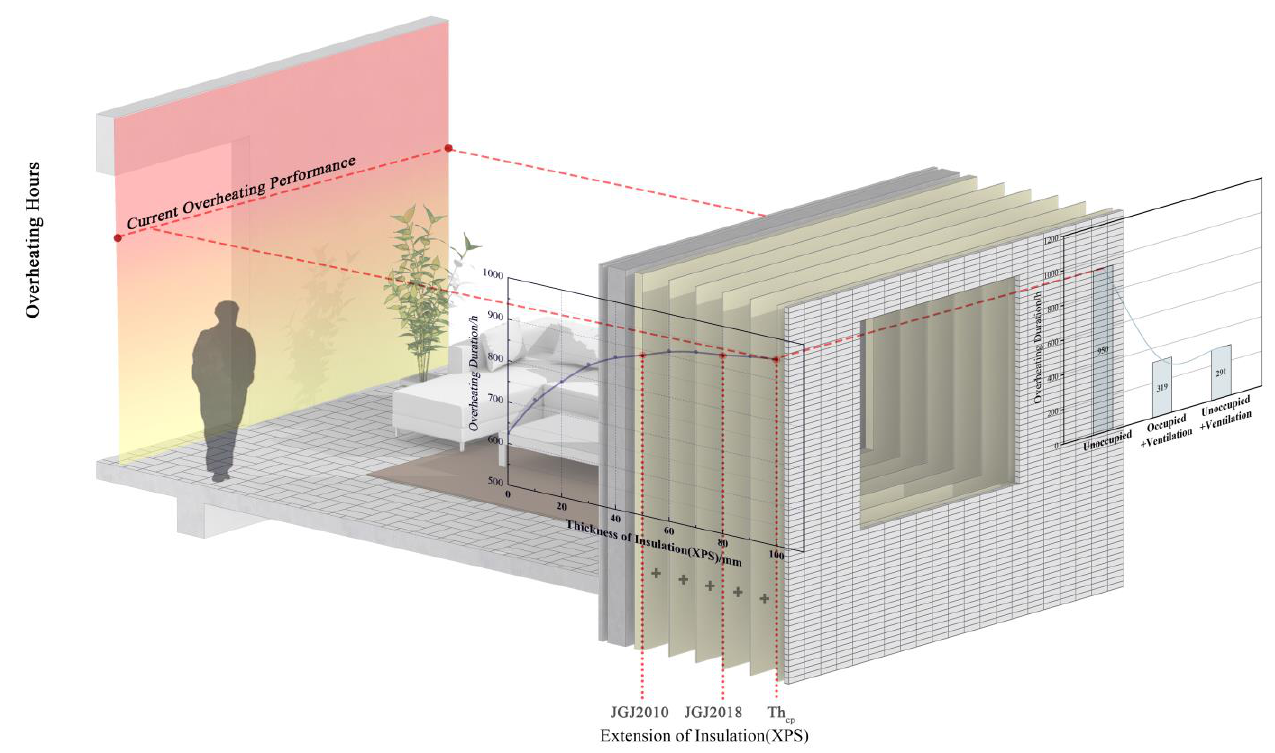
Figure 11. Comparisons of overheating performance over recent 15 years of the flats constructed with different Th insulation and under different types of scenarios in Harbin( Ⅰ B sub-region) (the left- handed line graph indicates the overheating duration in flats whose external walls’ U -values are the limit values in two versions of residential building design standards and current practice value; the right-handed line shows the overheating duration in the unoccupied flat without natural ventilation, unoccupied flat with night ventilation and occupied flat with night ventilation).